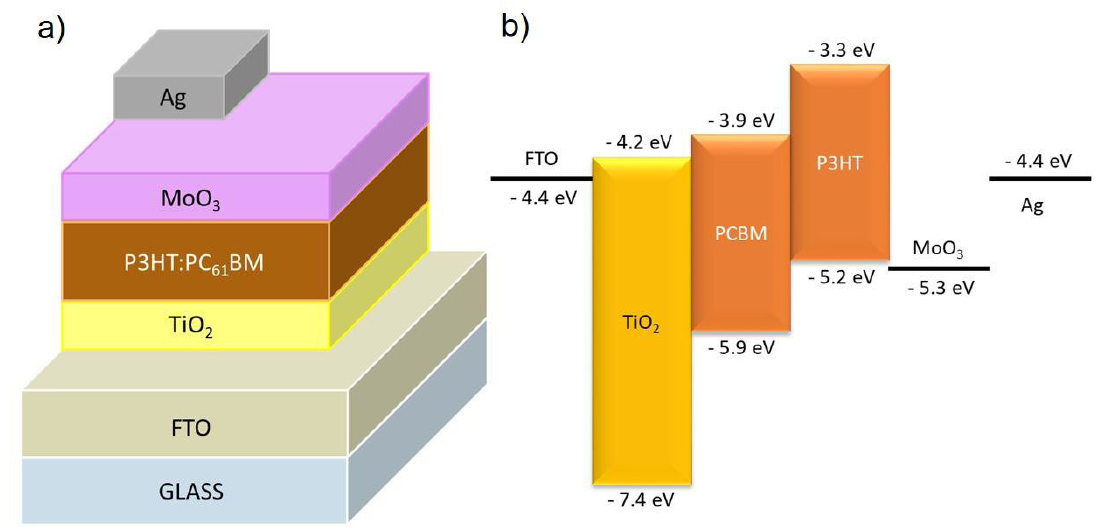
Figure 6. (a) Device structure and (b) energy level diagram of the fabricated OPV .